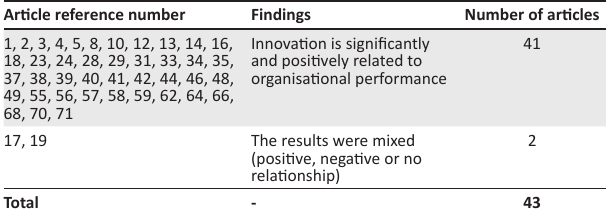
TABLE 4: Subjective measures of organisational performance.